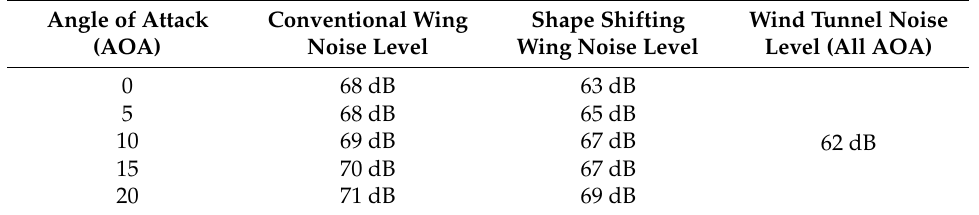
Table 2. Noise levels produced by the conventional wing and morphing wing at different angles of attack.